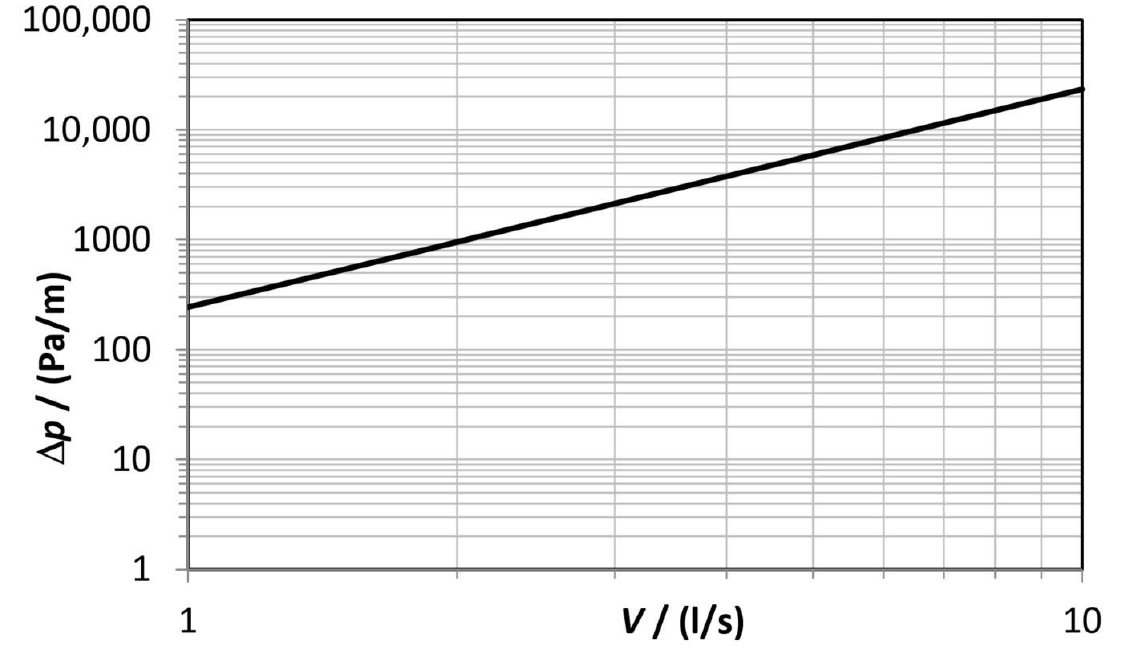
Figure 19. Hydraulic characteristic curve of the steel pipe